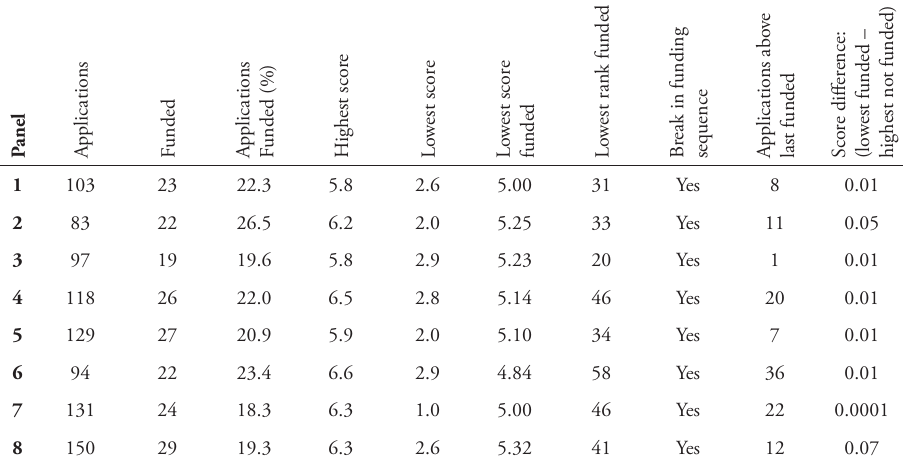
Table 1. Summary of grant applications, score evaluation, and numbers funded by an anonymous United Kingdom funding body from eight